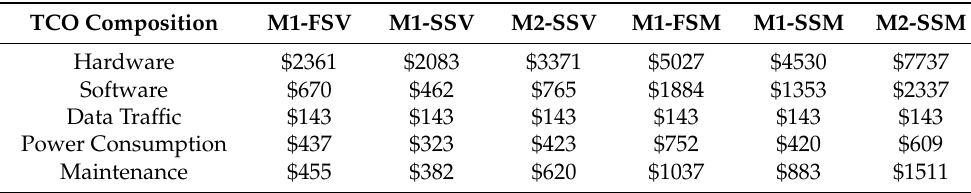
Table 6. Cost comparison of different development strategies. All costs are shown in USD. TCO Composition